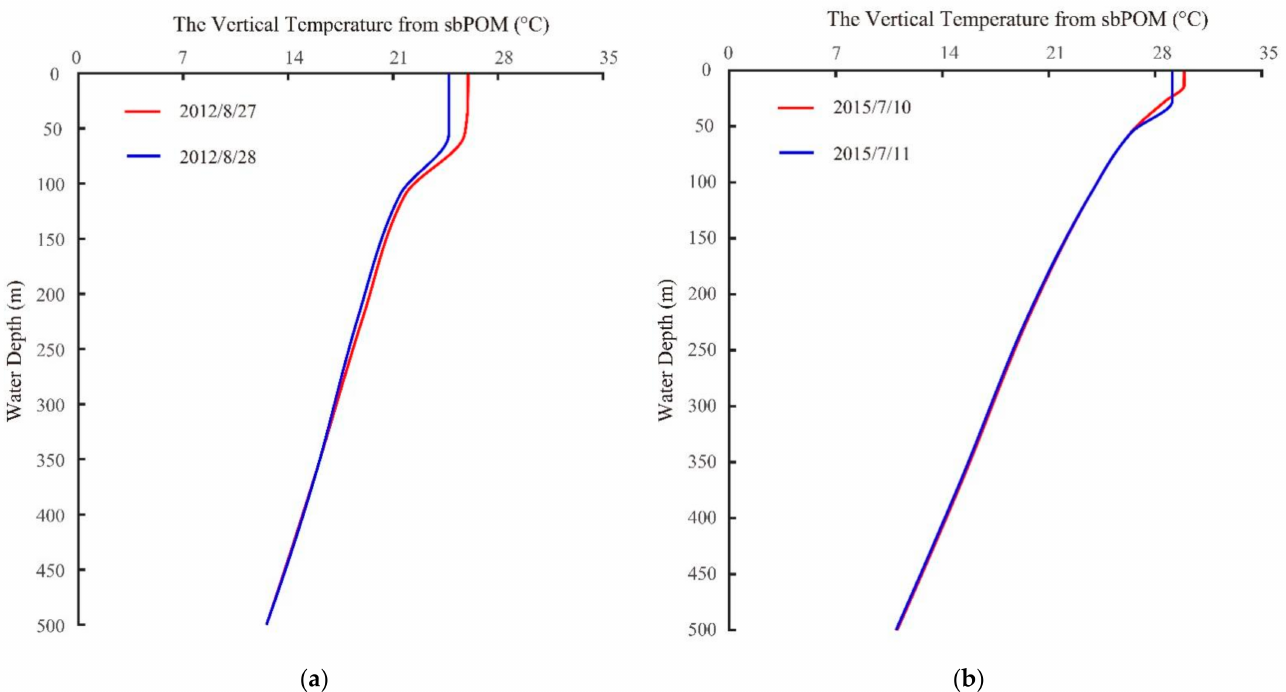
Figure 12. ( a ) The vertical temperature profile simulated using the sbPOM on 27 and 28 August 2012 at Site A in Figure 10a, and ( b ) the vertical temperature profile simulated using the sbPOM on 10 and 11 July 2015 at Site B in Figure